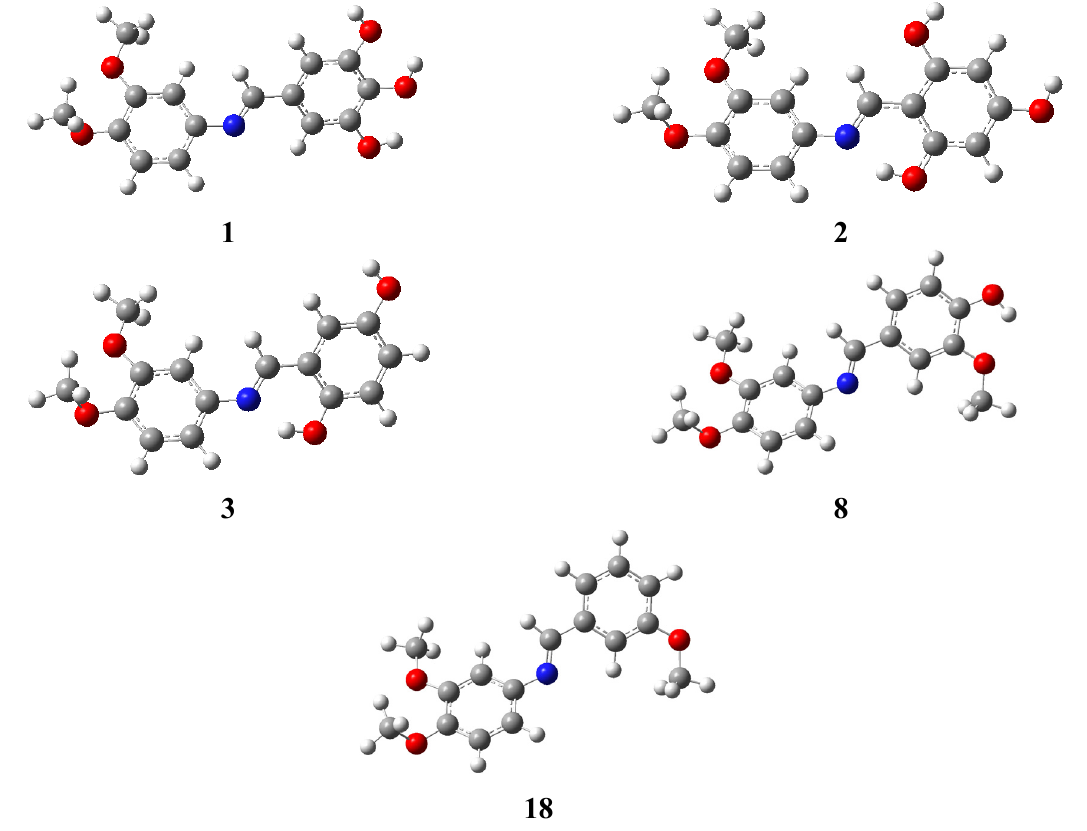
Figure 3. Optimized structures of compounds 1 , 2 , 3 , 8 and 18